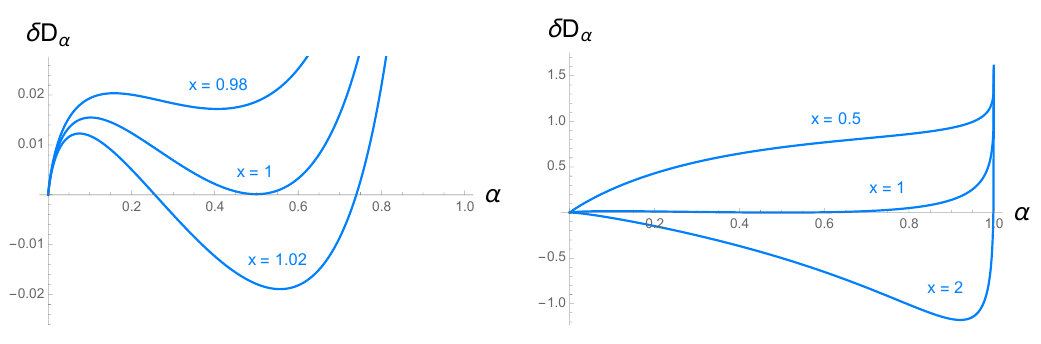
Figure 7 . (cid:14)D (cid:11) = D (cid:11) ( (cid:26) 1 k (cid:26)